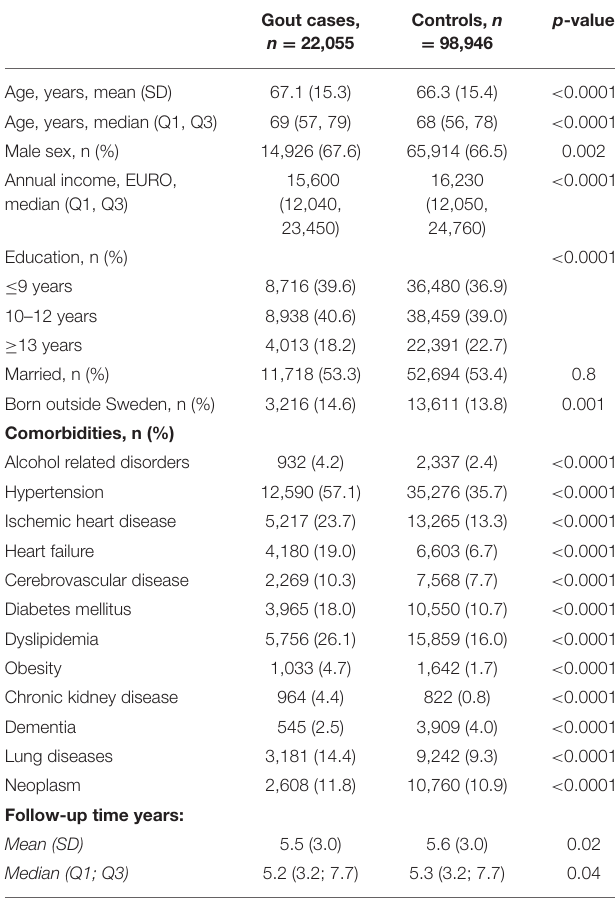
( Table 4 ). Death due to renal disease and diseases of the digestive system were significantly higher in gout overall, HR 1.53 (95%